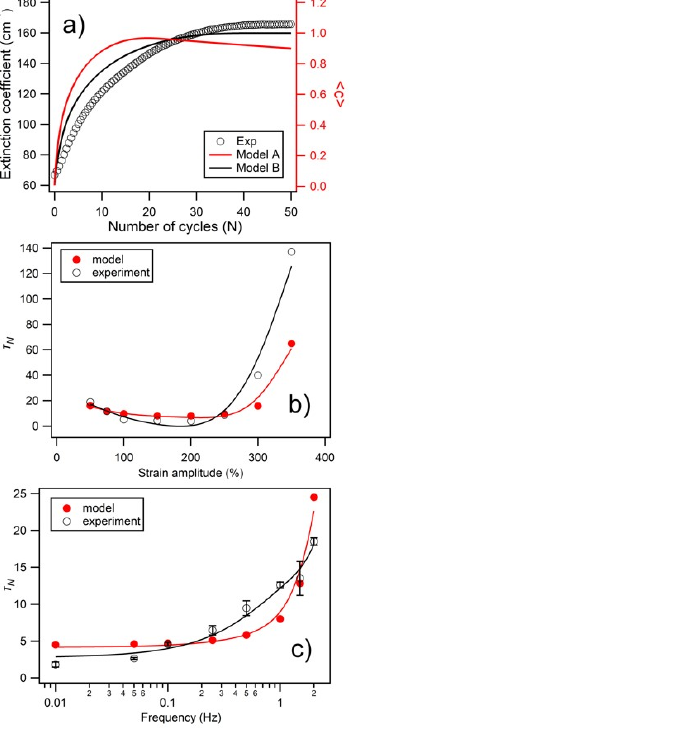
Figure 6. ( a ) Shows a representative side-by-side comparison of the experimental time evolution of the stopband extinction coefficient, with the directly corresponding simulation outputs for both Model A and Model B, in terms of the spatially averaged order parameter <c>. In this case, the temperature was 50 ◦ C, frequency = 1 Hz, and shear amplitude = 150%. ( b ) Strain dependence of τ N at 50 ◦ C and frequency = 1 Hz, comparing the simulation model and experimentally derived values as indicated. ( c ) Shows the corresponding frequency dependence at strain amplitude 150%. In the lower two graphics, indicative trendlines are added, using smoothing spline